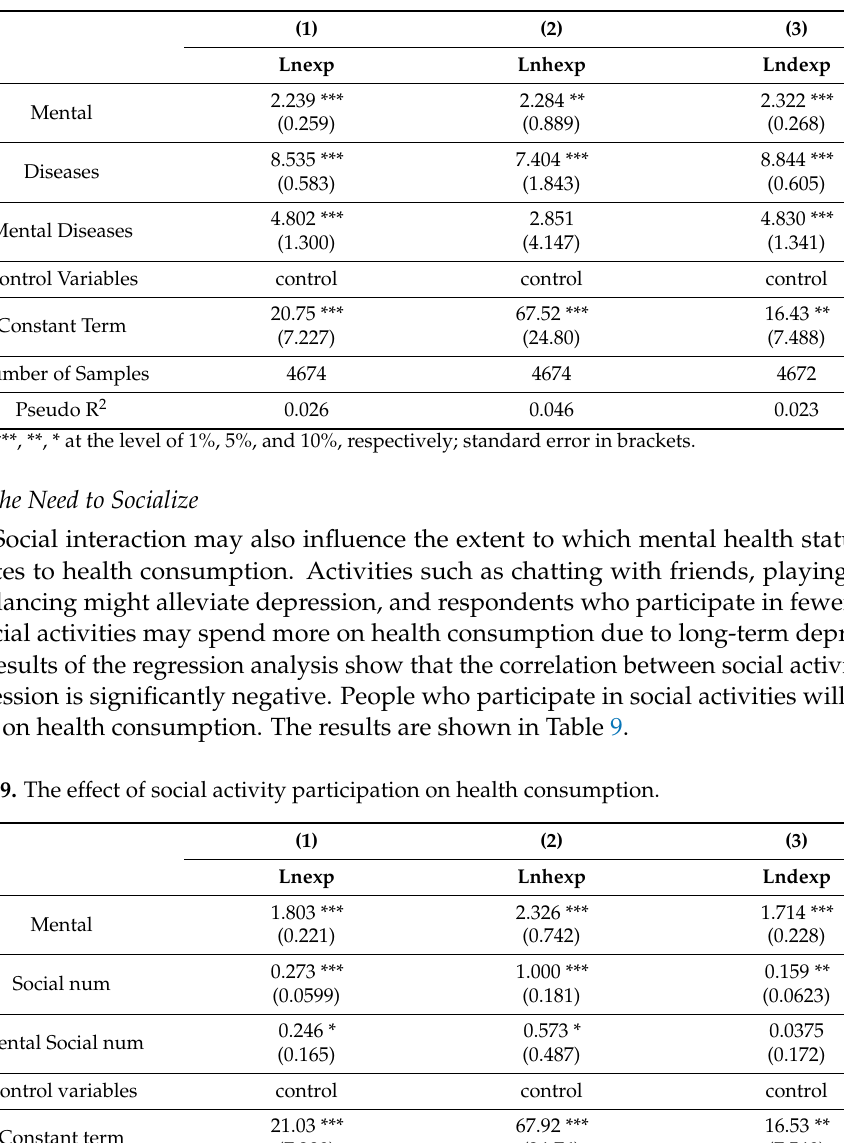
Table 8. Regulating effect of chronic disease on mental health and health consumption.